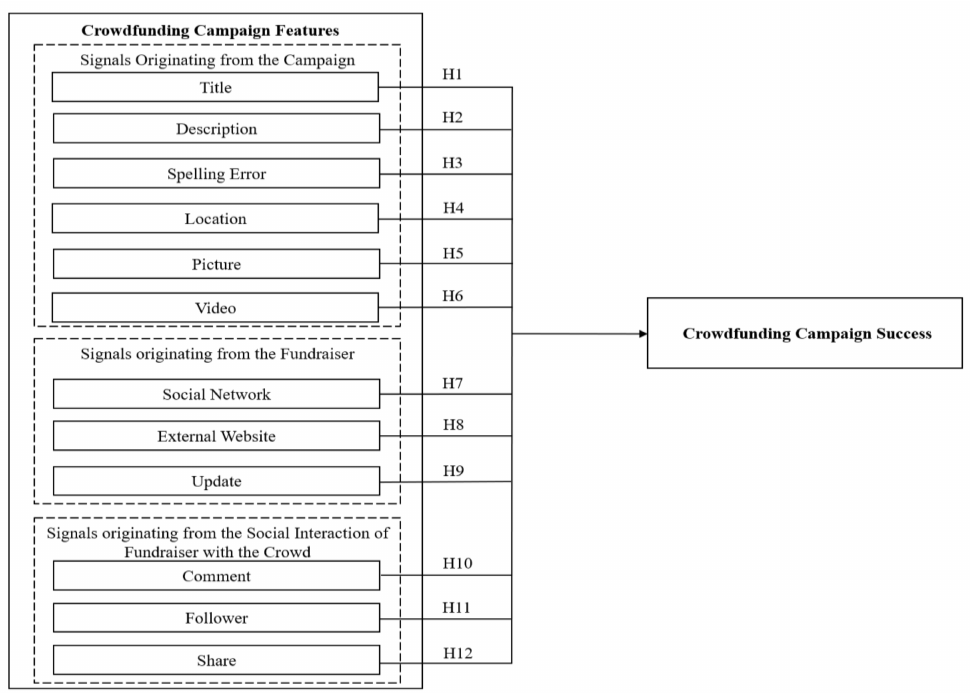
Figure 1. Proposed research